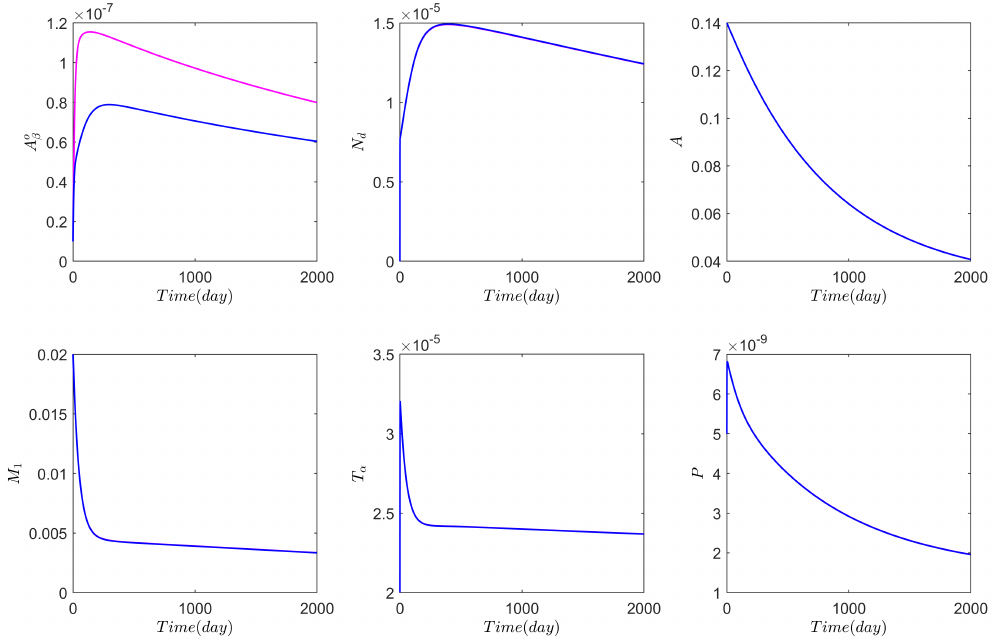
Figure 4. Average solutions of the six variables associated with astrocytes and microglias. We take all the parameter values from Tables 1 and 2 with λ AA o curve curves correspond to the absence and presence of anti- A β drug,